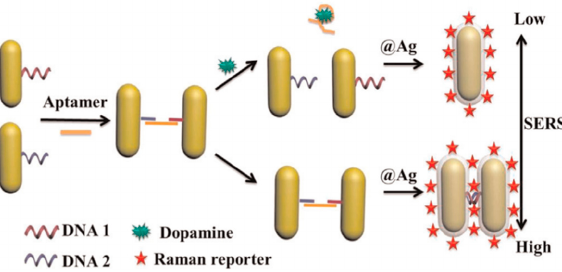
Figure 9. Schematic diagram of dopamine detection using bimetallic Au@Ag nanorod dimers, Raman reporter of 4-aminothiophenol, and aptamer. Adapted from [11].